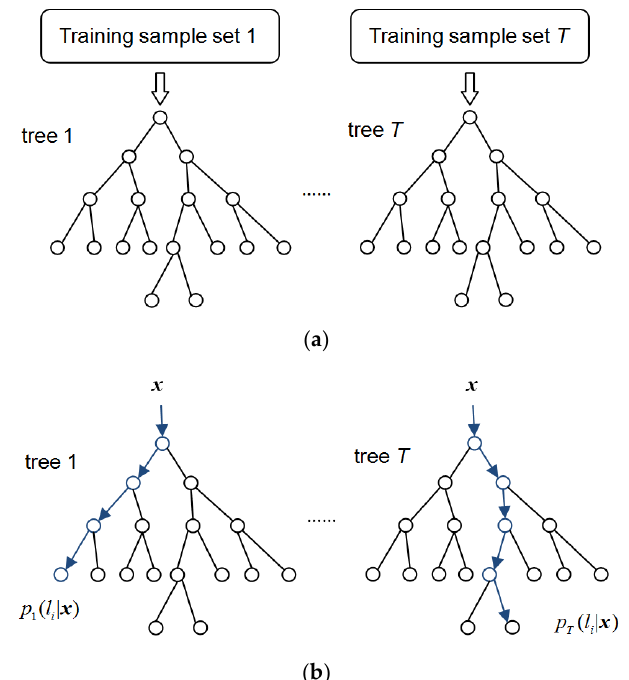
Figure 4. The training and predicting process of the random decision forest. ( a ) The training process. ( b ) The predicting process.